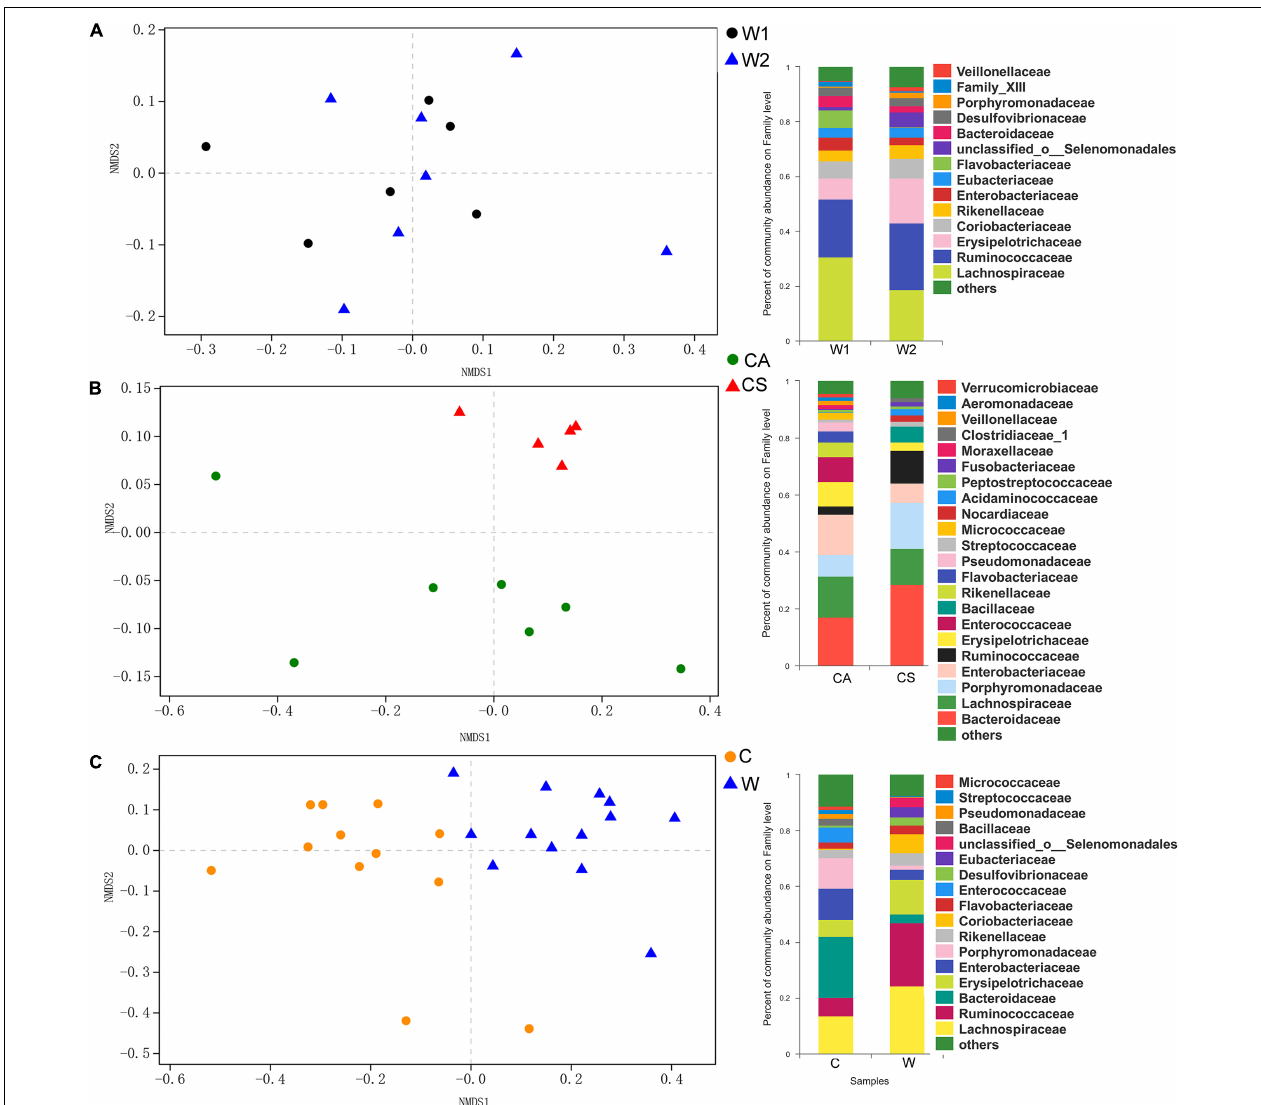
FIGURE 2 | Non-metric multidimensional scaling (NMDS) plot based on the weighted UniFrac distance matrix between the gut bacterial communities of ( A , left) the W1 (juvenile) and W2 (adult) groups of wild frogs, ( B , left) the CS (summer) and CA (autumn) groups of captive frogs, and ( C , left) the C (captive frogs) and W (wild frogs) groups. Composition (at the family level) of the gut bacterial communities of ( A , right) juvenile and adult wild frogs, ( B , right) the summer and autumn groups of captive frogs and ( C , right) captive and wild frogs.